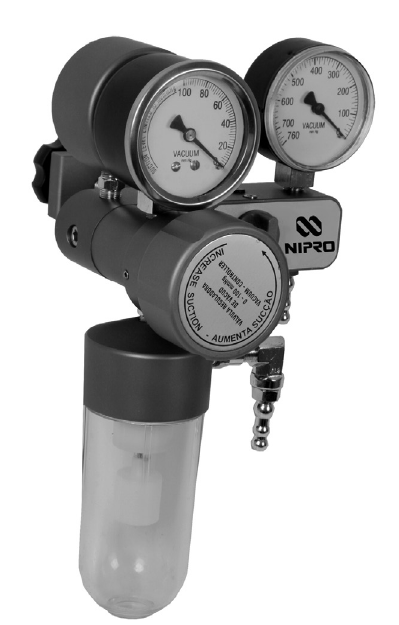
Fig. 1 - Conjunto de válvulas que regula a pressão negativa fornecida pela